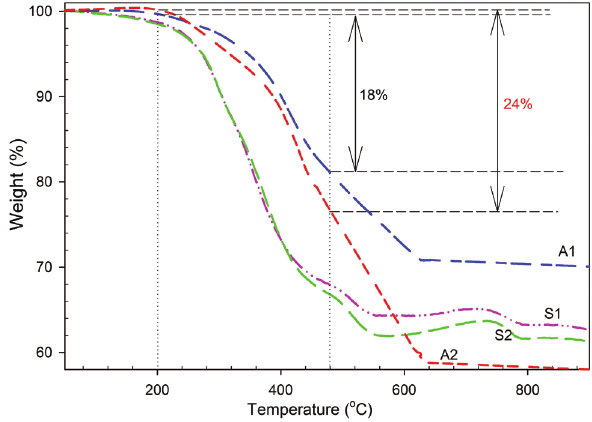
Figure 10 TGA spectra of BHJSC active layer blends A1, A2, and S2 (heating rate: 10 ° C/min, O 2